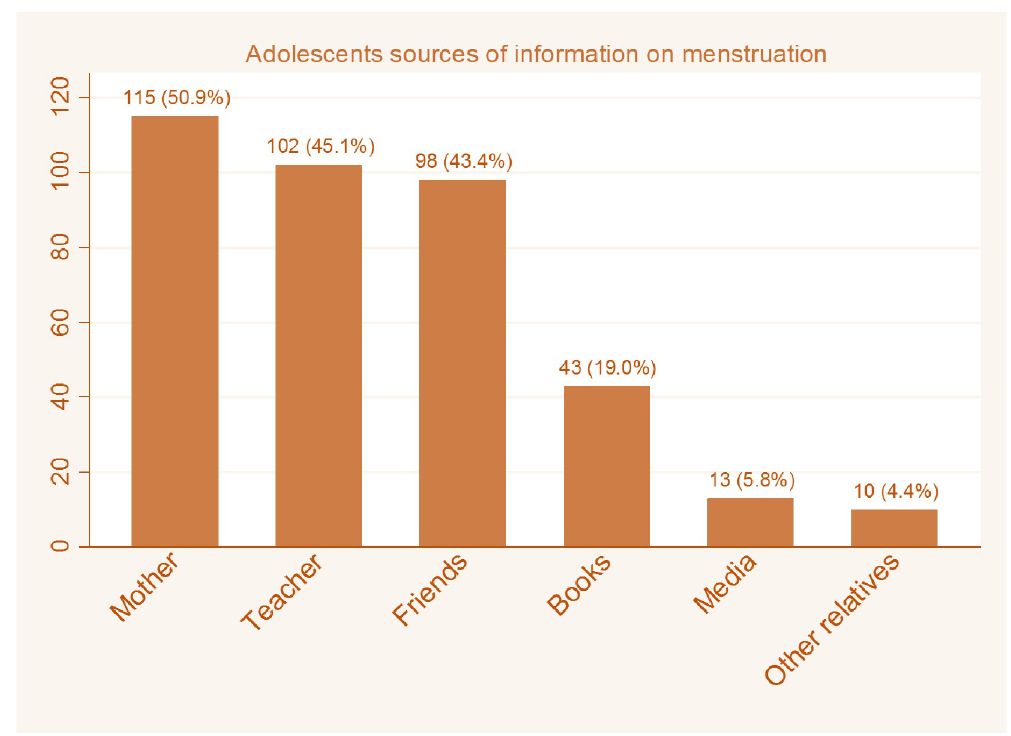
Fig 2. Adolescents sources of information about menstruation.